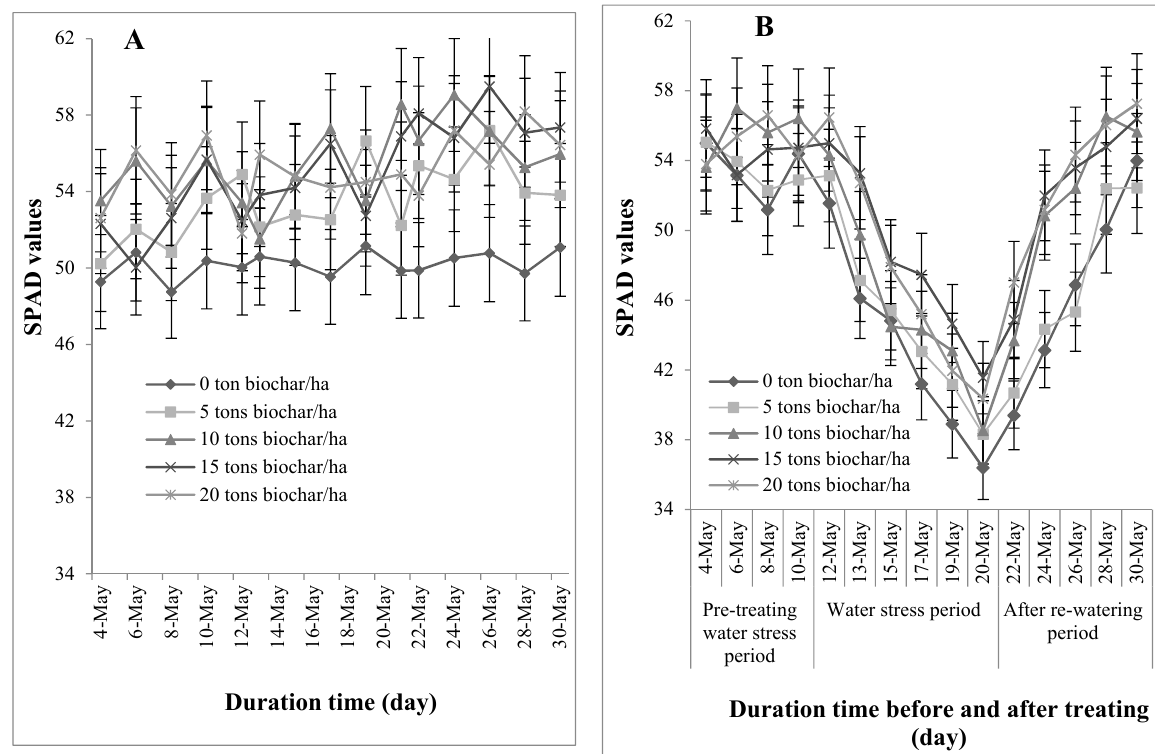
Figure 2. Effect of biochar on SPAD values of Ehretia asperula under non-WSC ( A ) and WSC ( B ). Vertical bars represent the mean ± SD, n = 15.